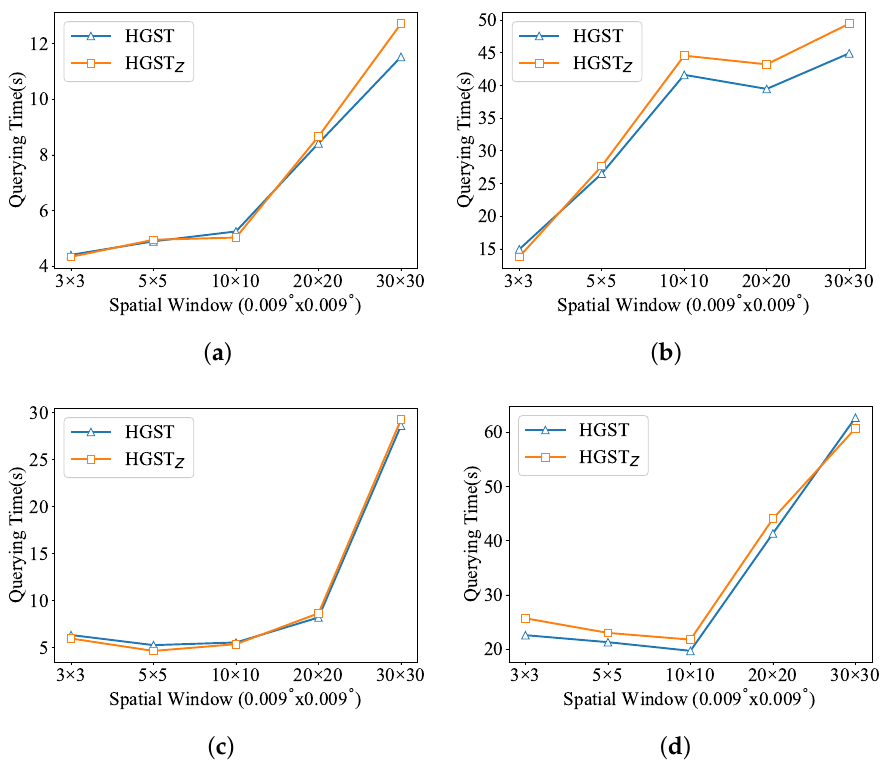
Figure 15. The effect of Hilbert filling curves on spatio-temporal range query. ( a ) Forbidden City (time window = 1 h); ( b ) Forbidden City (time window = 3 days); ( c ) Beijing West Railway Station (time window = 1 h); ( d ) Beijing West Railway Station (time window = 3